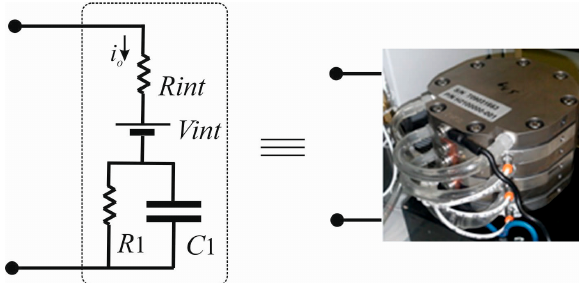
Figure 8. Picture of the adopted equivalent model ( left ) and PEM-EL ( right ).